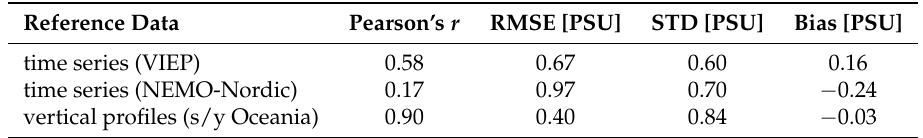
Table 6. Statistical comparison between modeled salinity and reference data from in situ measurements (VIEP and s/y Oceania) and numerical data